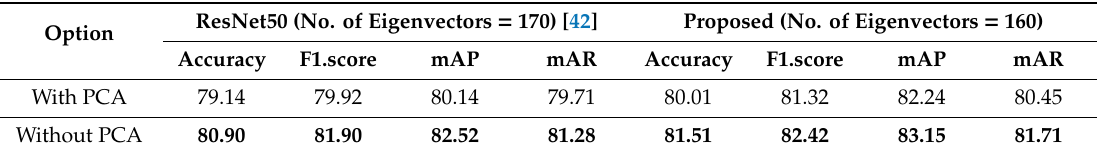
Figure 14. Principal component analysis (PCA)-based performance analysis. ( a ) ResNet50 [42]: features selected from the last average pooling layer; ( b ) proposed model: features selected from the last convolutional layer. Table 8. Principal component analysis (PCA) performance comparisons of our proposed and the second-best CNN model (ResNet50 [42]) (unit: %).